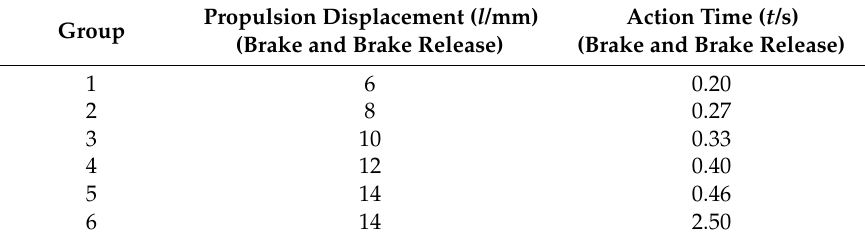
Table 2. Testing